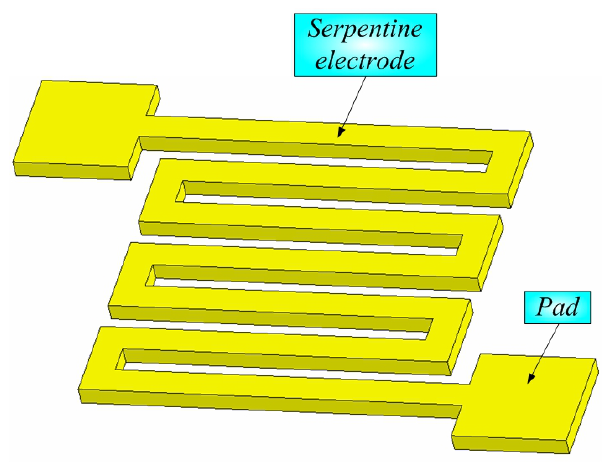
Figure 1. Structure of micro temperature